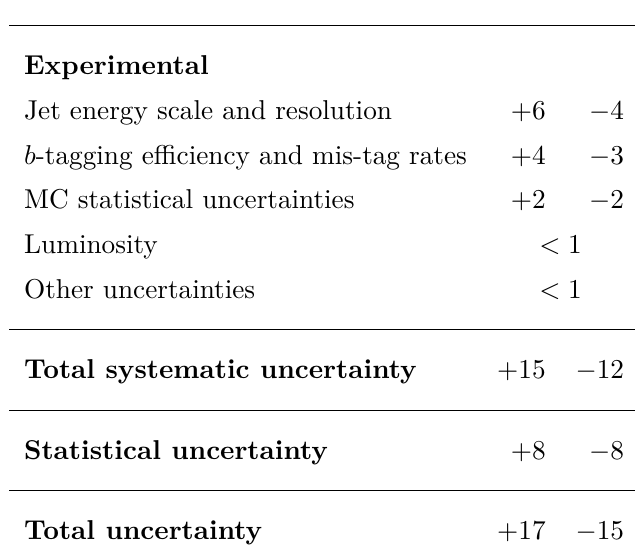
obtained t ¯ tt ¯ t